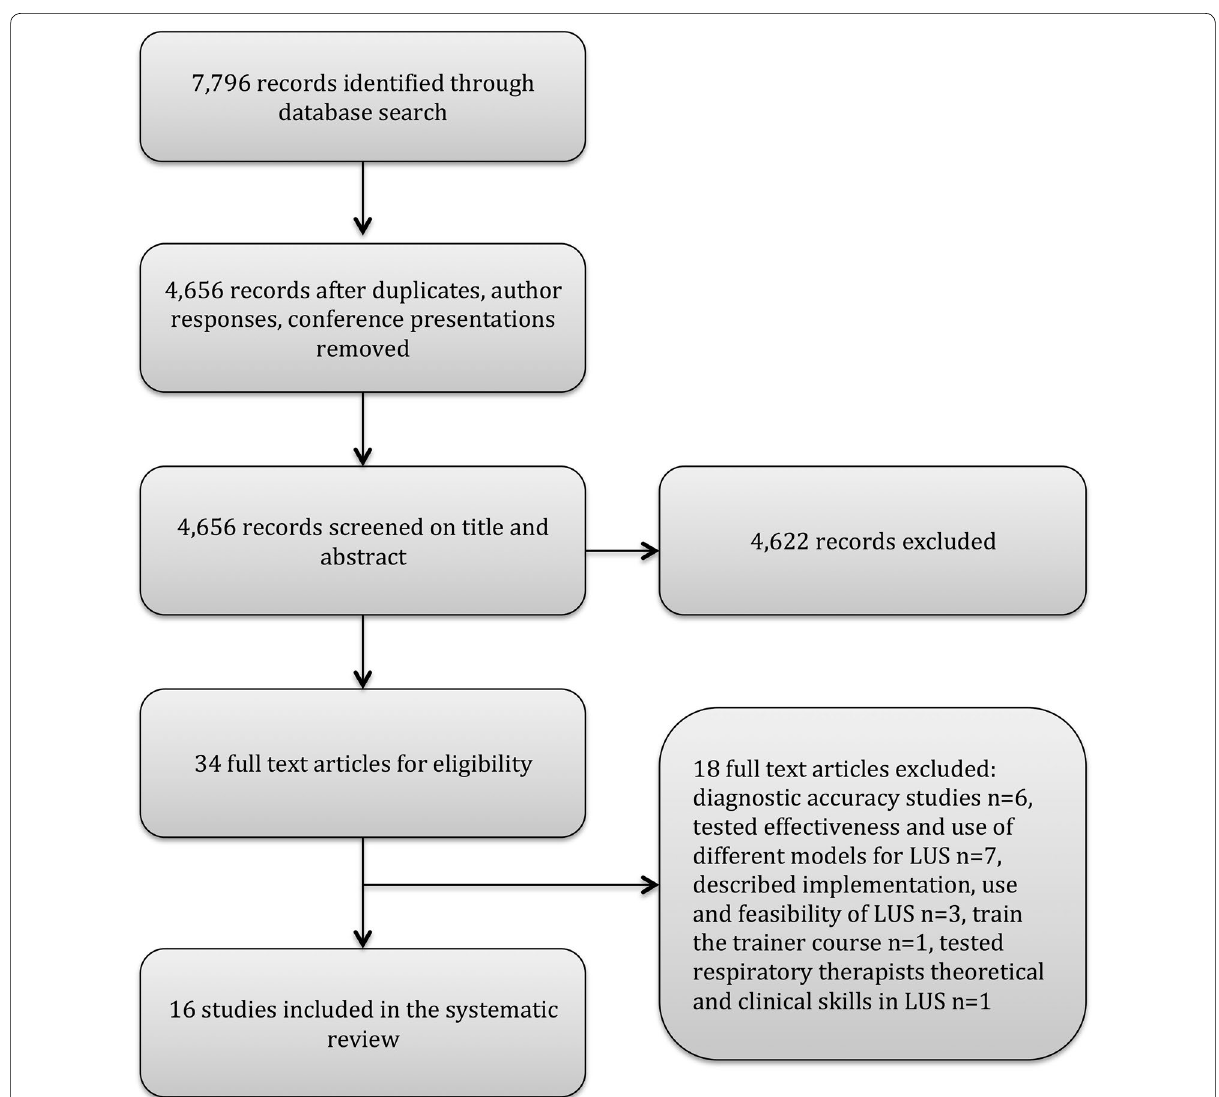
Fig. 1 Flowchart of search strategy, and selection process based on the Preferred Reporting Items for Systematic Reviews and Meta-analysis